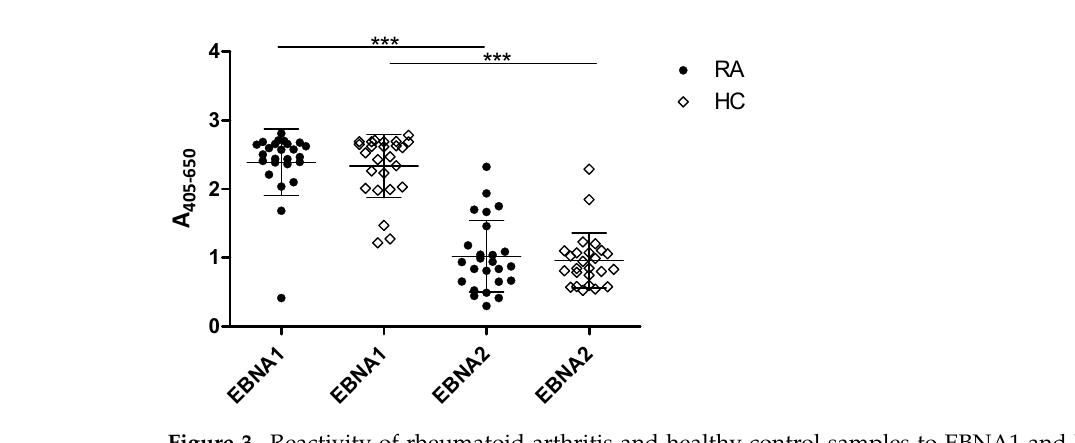
Figure 3. Reactivity of rheumatoid arthritis and healthy control samples to EBNA1 and EBNA2 full-length proteins analyzed using enzyme-linked immunosorbent assay. *** = p < 0.001. Next, the serologic levels of the biomarkers RF IgA and IgM were analyzed by ELISA (Figure 4). In this, 96% and 92% of the RA samples were positive for RF IgA and RF IgM, respectively; moreover, two HCs tested positive for RF IgA and IgM.